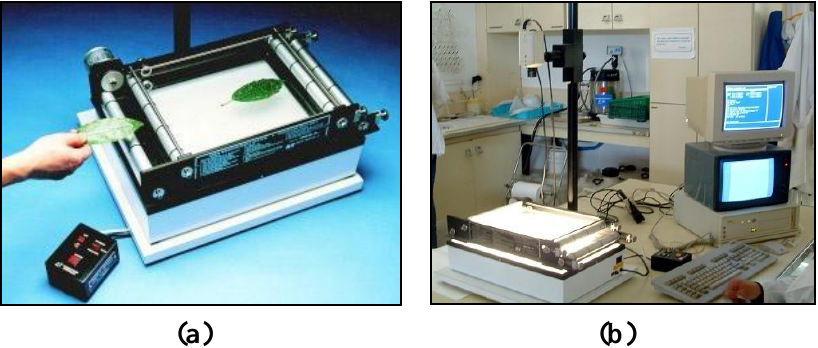
Figure 7. (a) Detailed Photograph of the Area Measurement System-Conveyor Belt Unit (Delta-T Devices Ltd.). (b) Photograph of all the equipment in the